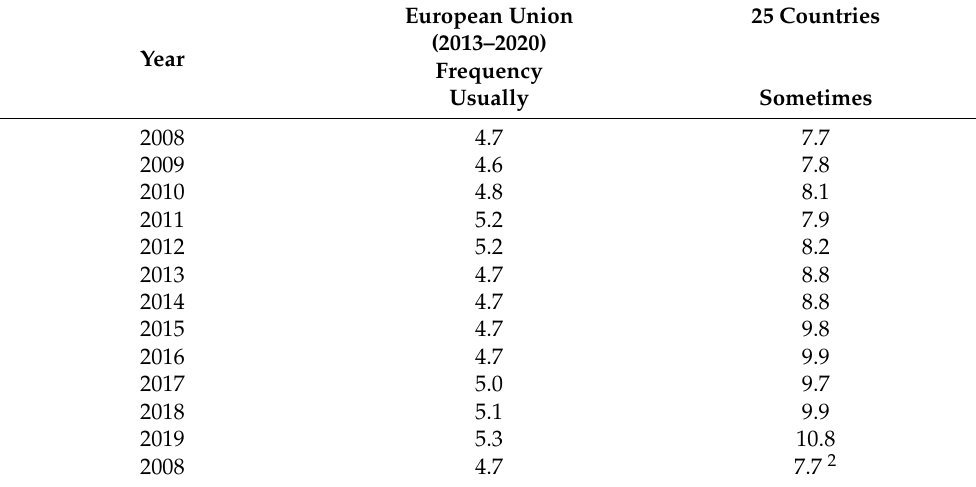
Table 2. Teleworking in Europe